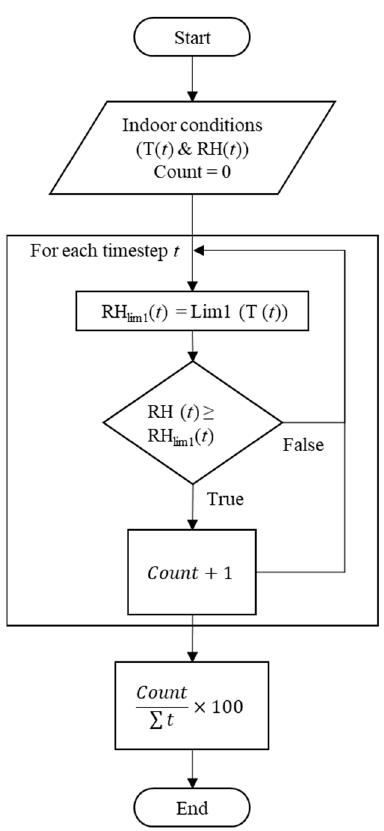
Figure A1. Procedure for assessing the biological decay developed in MATLAB.